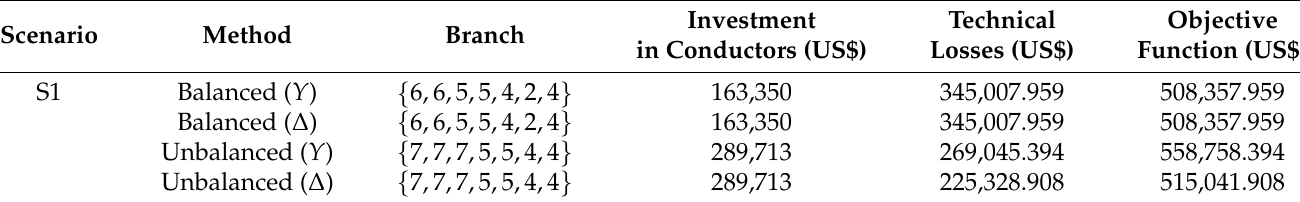
Table 25. Comparative analysis for the 8-bus system with loads with ∆ - and Y -connections.